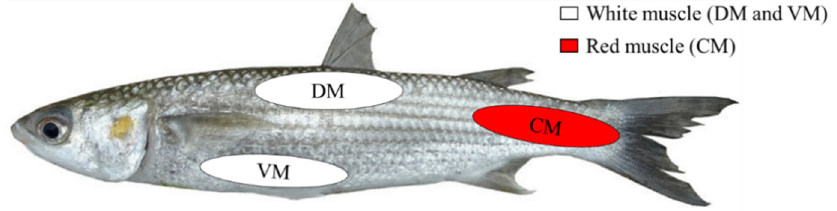
Figure 2. Sampling areas for C. auratus and C. saliens . Ventral muscle (VM), dorsal muscle (DM) and caudal muscle (CM).